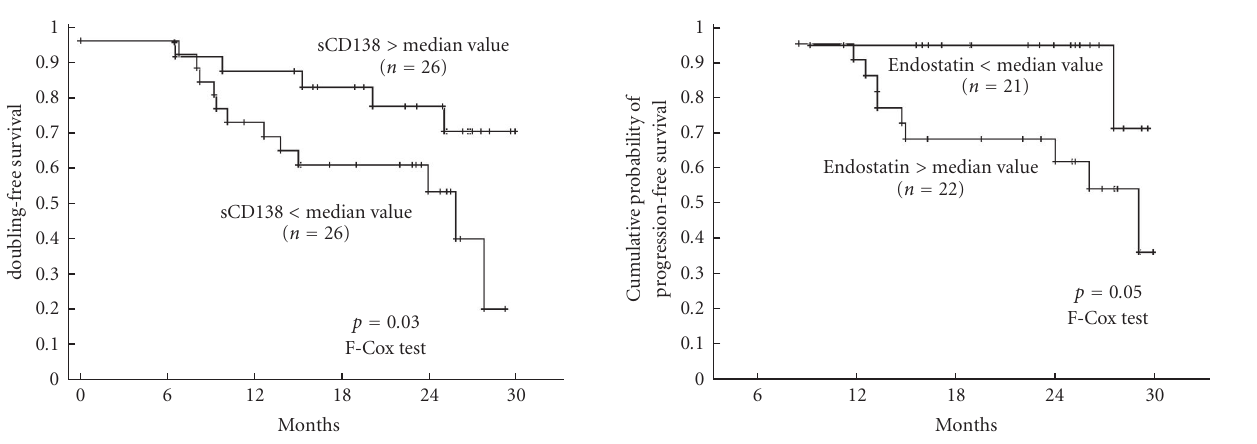
Figure 2: Cumulative probability of lymphocyte doubling-free sur- vival in 52 untreated CLL patients stratified on the basis of median value of sCD138 (ie, 149.03 ng/mL).